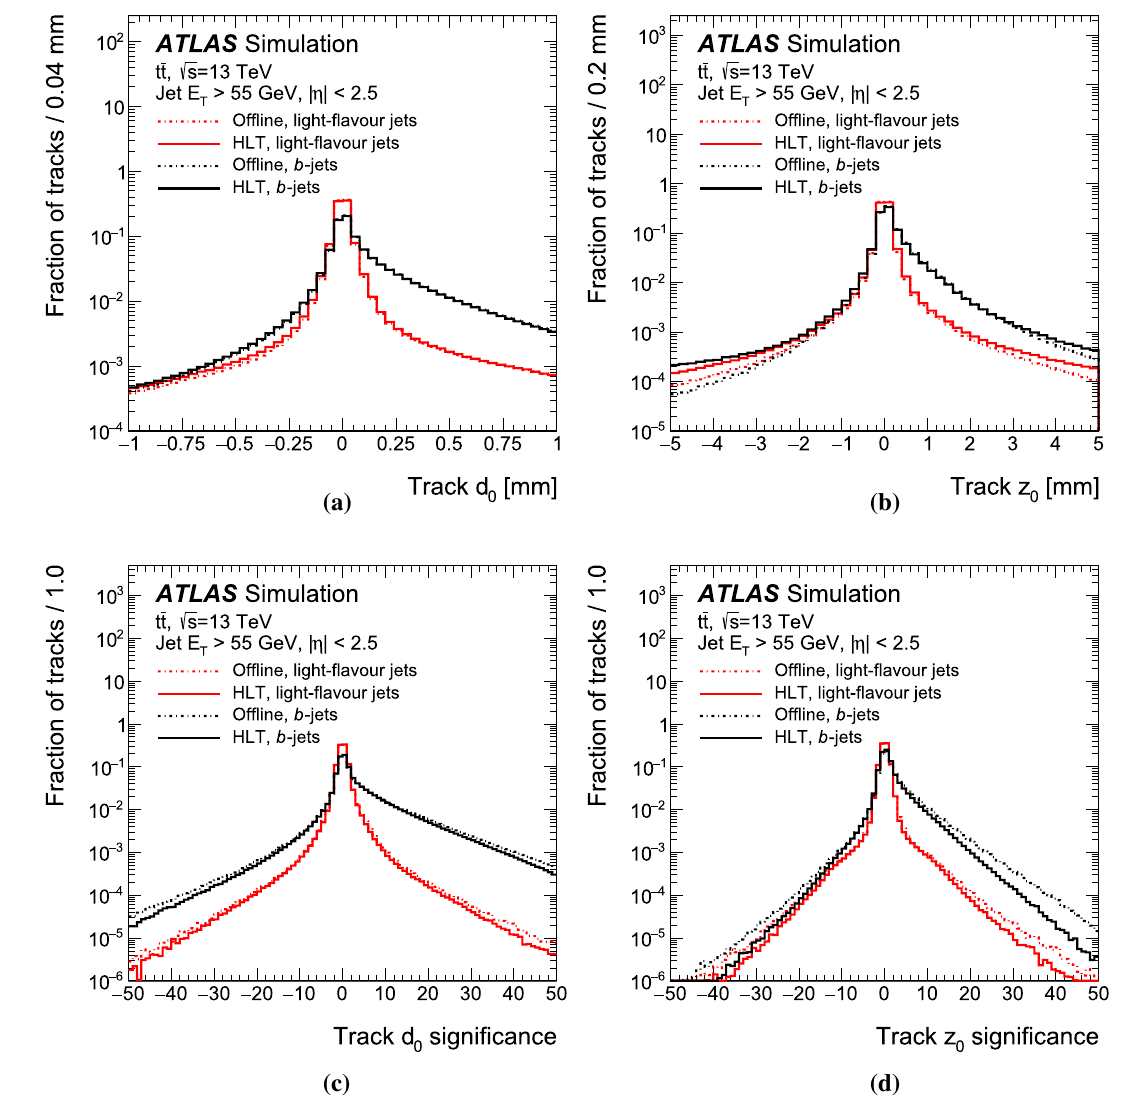
Fig. 8 The a transverse, and b longitudinal track impact parameters, and c , d their corresponding significances for b -jets and light-flavour jets. The distributions show both the online and offline versions of these quantities